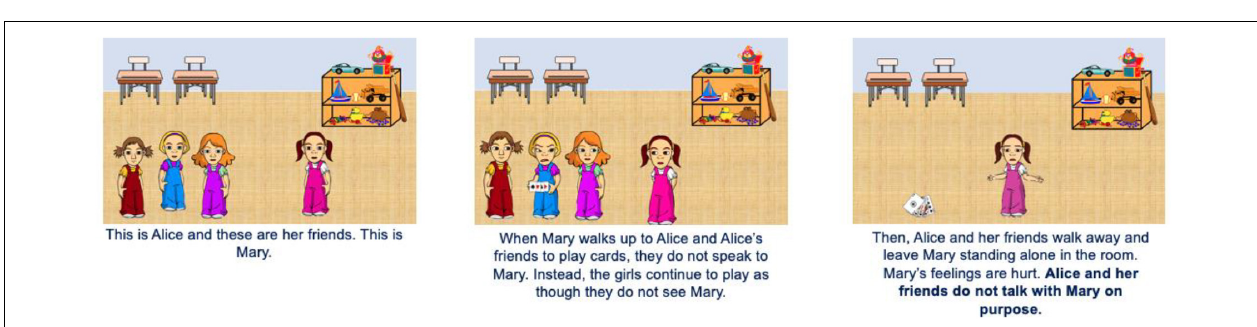
Frontiers in Psychology |